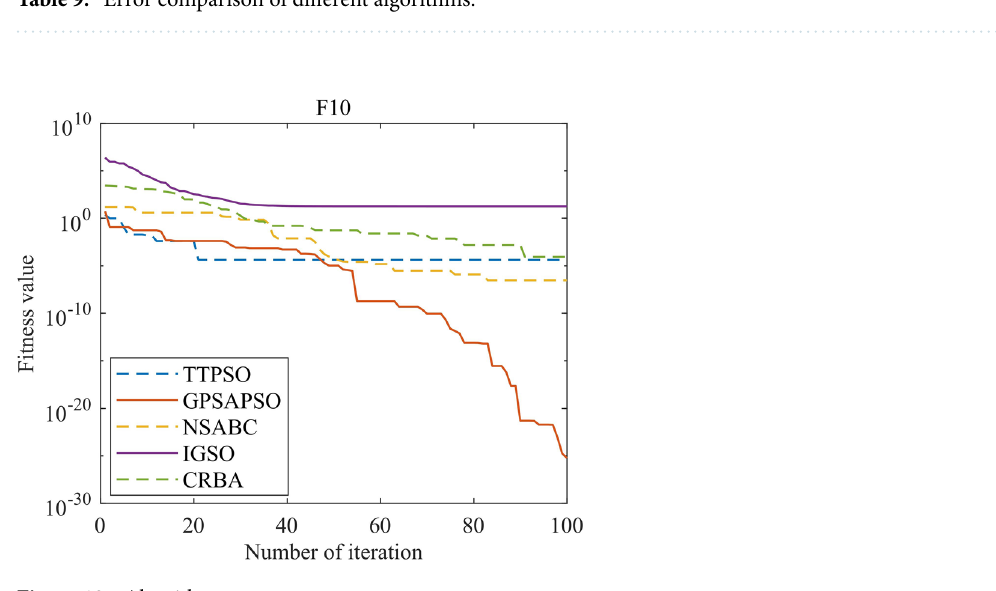
Figure 10. Algorithm convergence